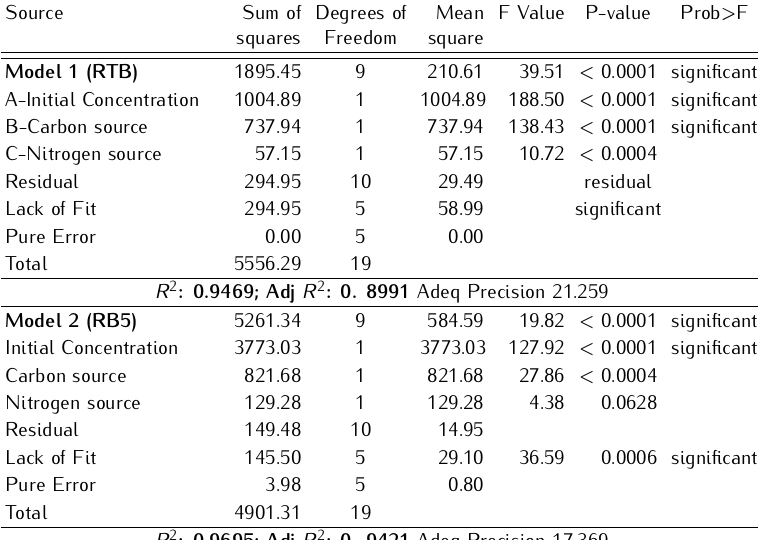
Table 5. Analysis of variance (ANOVA), results for decolourization of Congo red and Reactive Red 195 by Pseudomonas sp